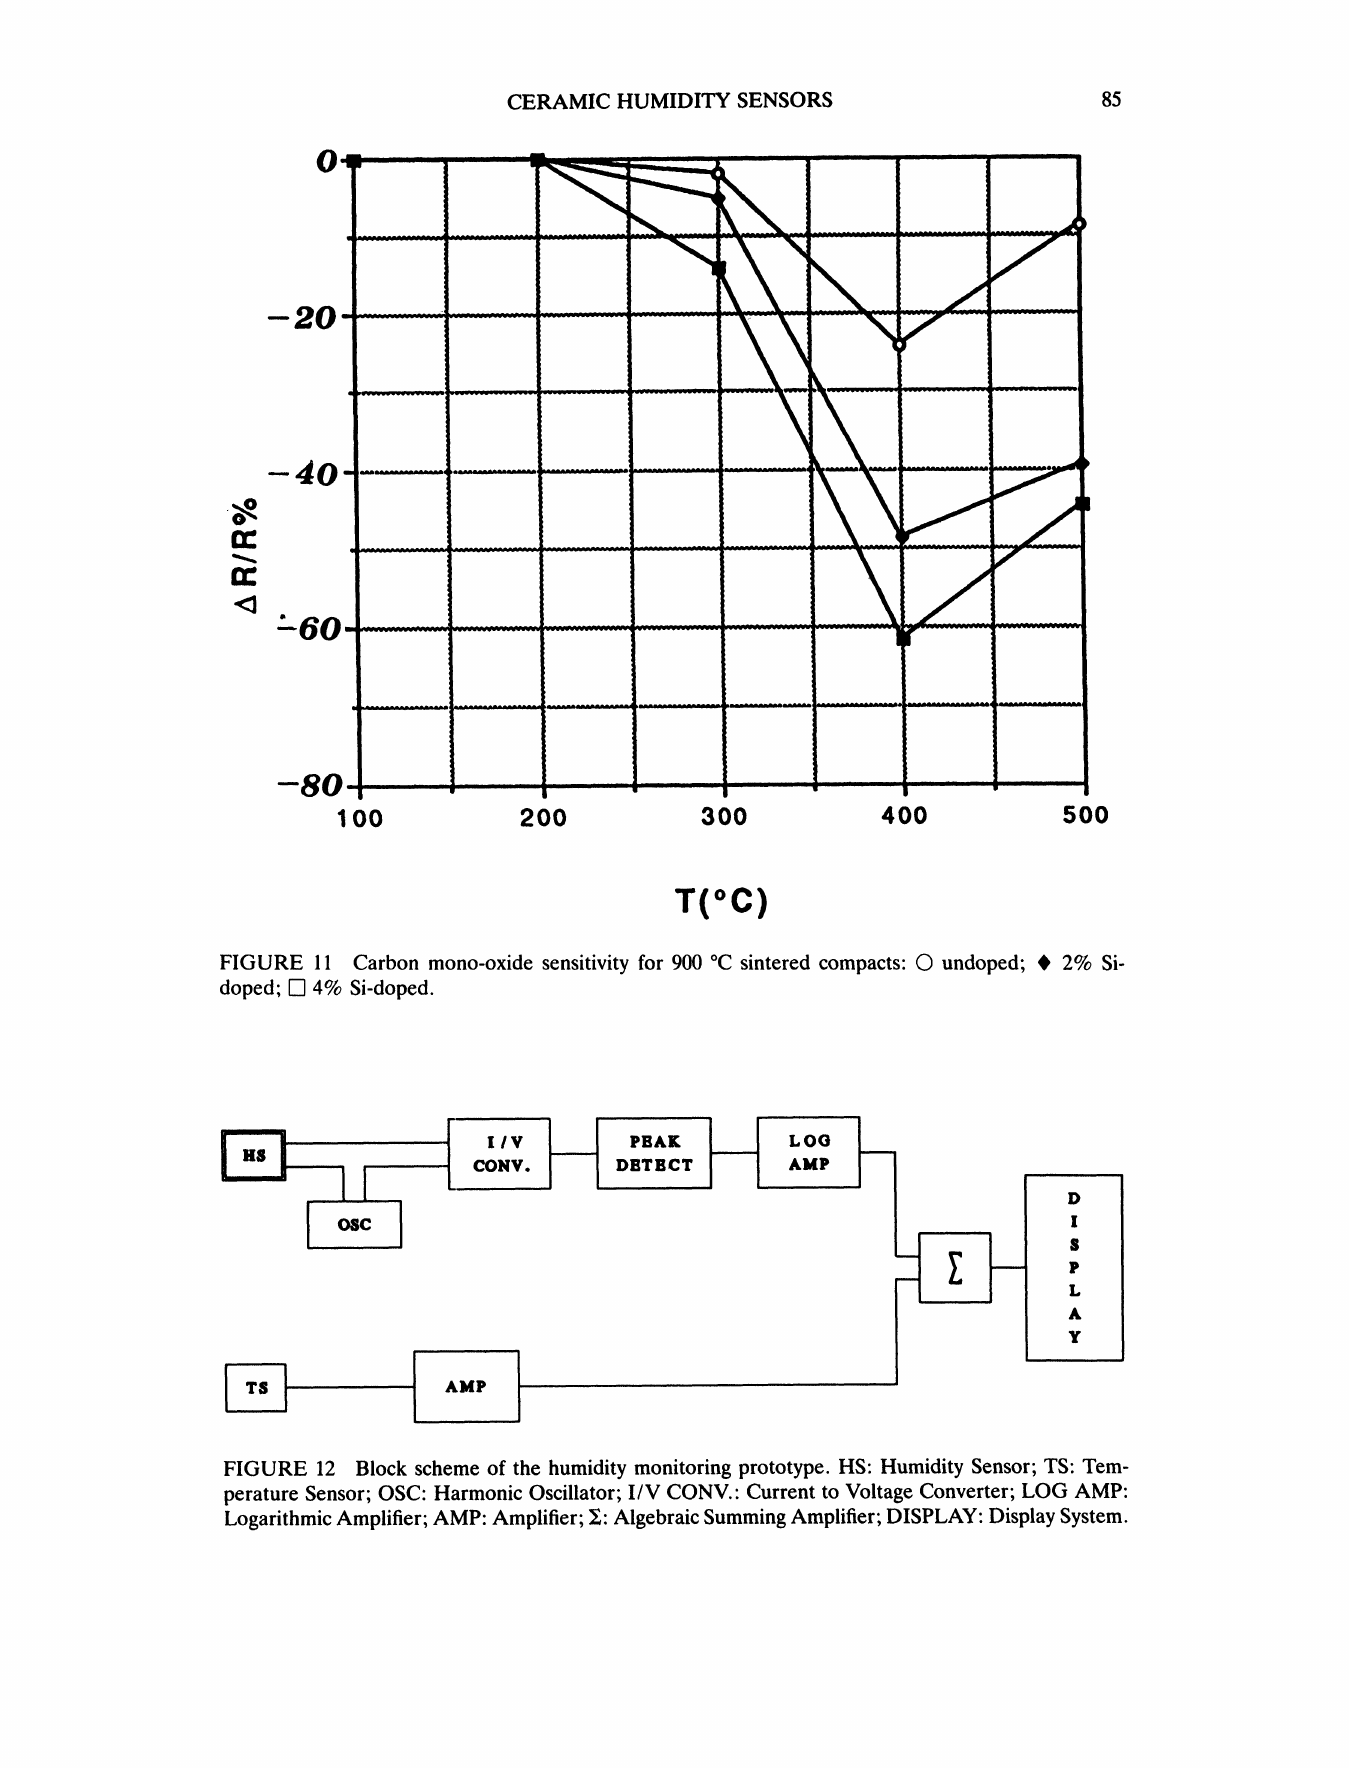
FIGURE 12 Block scheme of the humidity monitoring prototype. HS: Humidity Sensor; TS: Tem- perature Sensor; OSC: Harmonic Oscillator; I/V CONV." Current to Voltage Converter; LOG AMP: : Algebraic Summing Amplifier; DISPLAY: Display Logarithmic Amplifier; AMP: Amplifier;